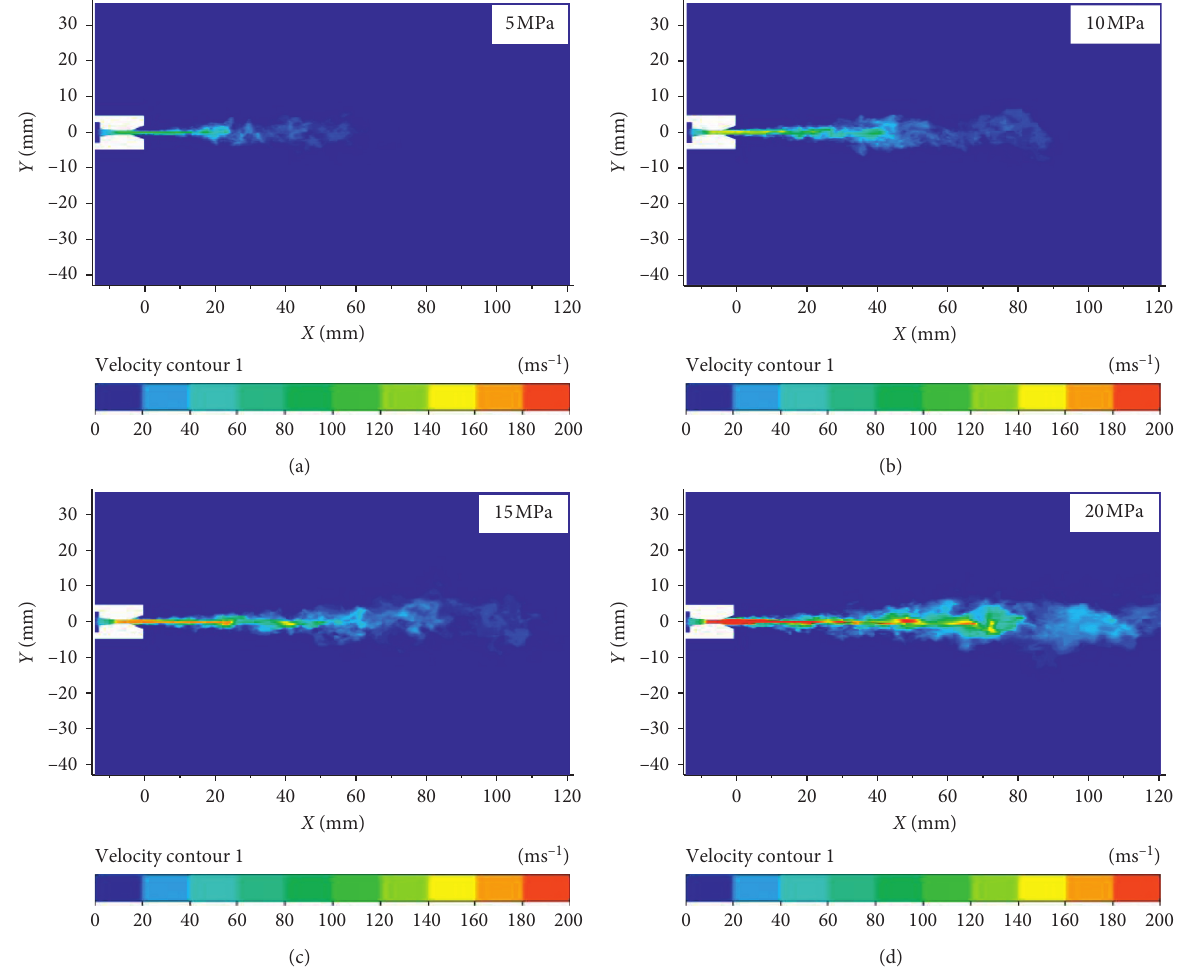
Figure 15: Velocity magnitude under different cavitation numbers. (a) σ � 0.0203. (b) σ � 0.0101. (c) σ � 0.0068. (d) σ � 0.0051.